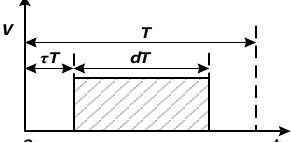
Figure 3. Typical pulse width modulation (PWM) waveform.